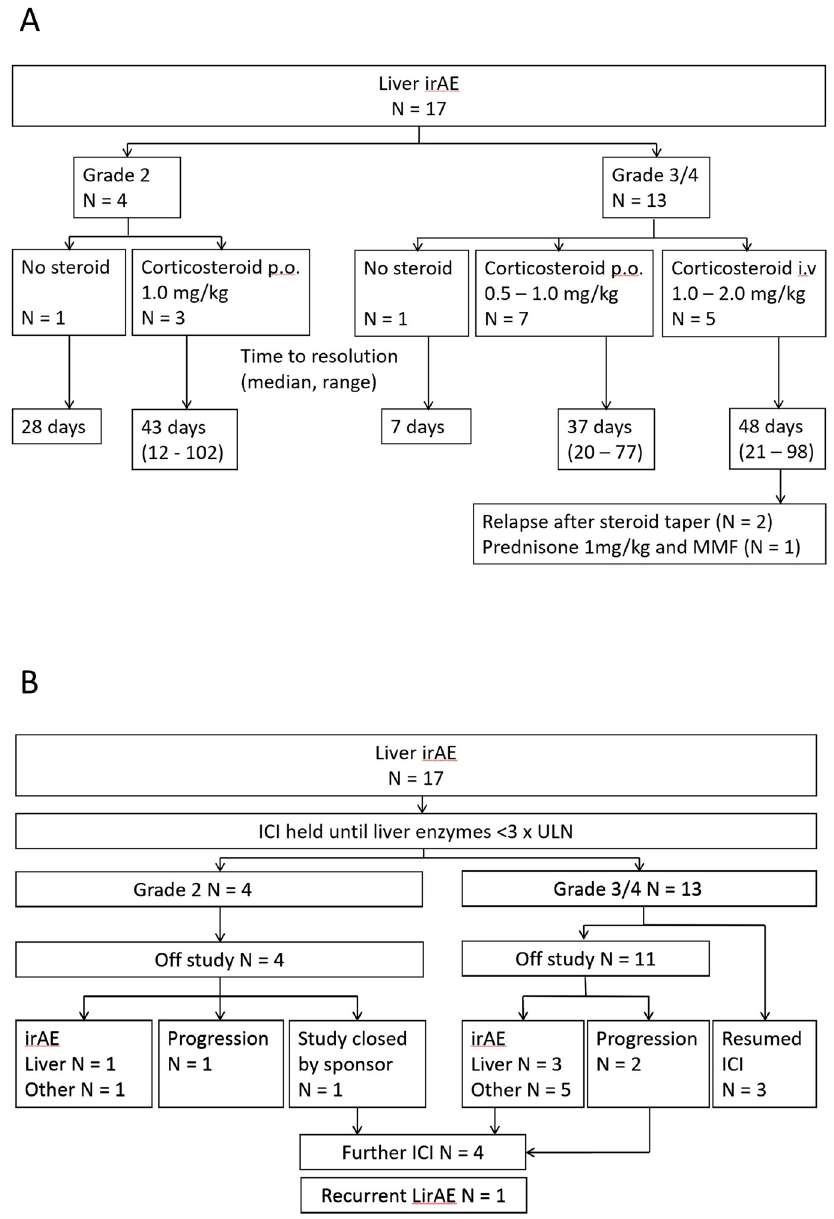
Fig 3. Management of patients diagnosed with liver immunotoxicity due to checkpoint inhibitor (ICI) immunotherapy, according to severity of enzyme elevation. A , duration and route of immunosuppressive therapy and time to resolution of elevated liver enzymes. B , management of ICI therapy following diagnosis of liver immunotoxicity. ULN, upper limit of normal; irAE, immune-related adverse event; LirAE, liver immune-related adverse event; MMF, mycophenolate